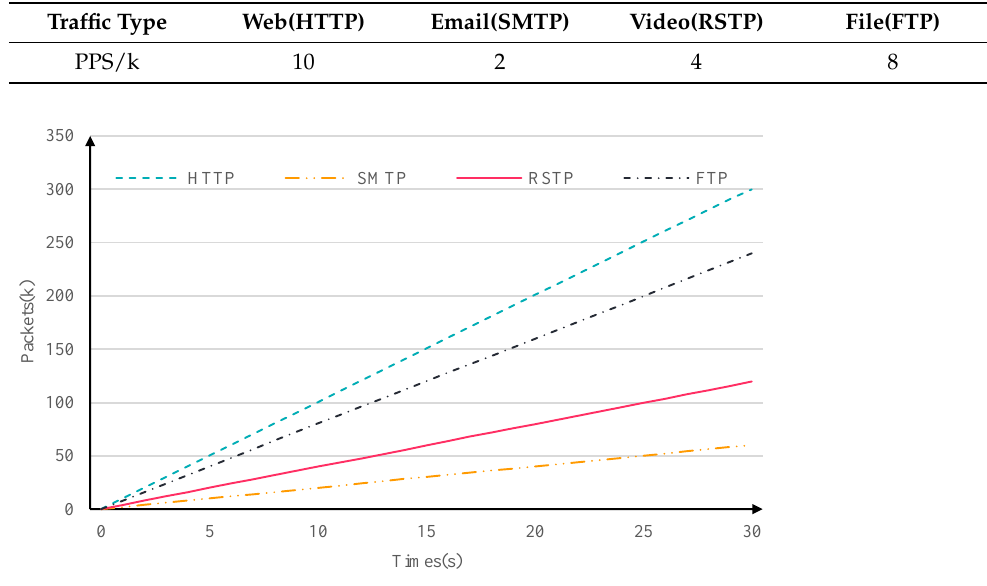
Table 2. Traffic configuration ratio.